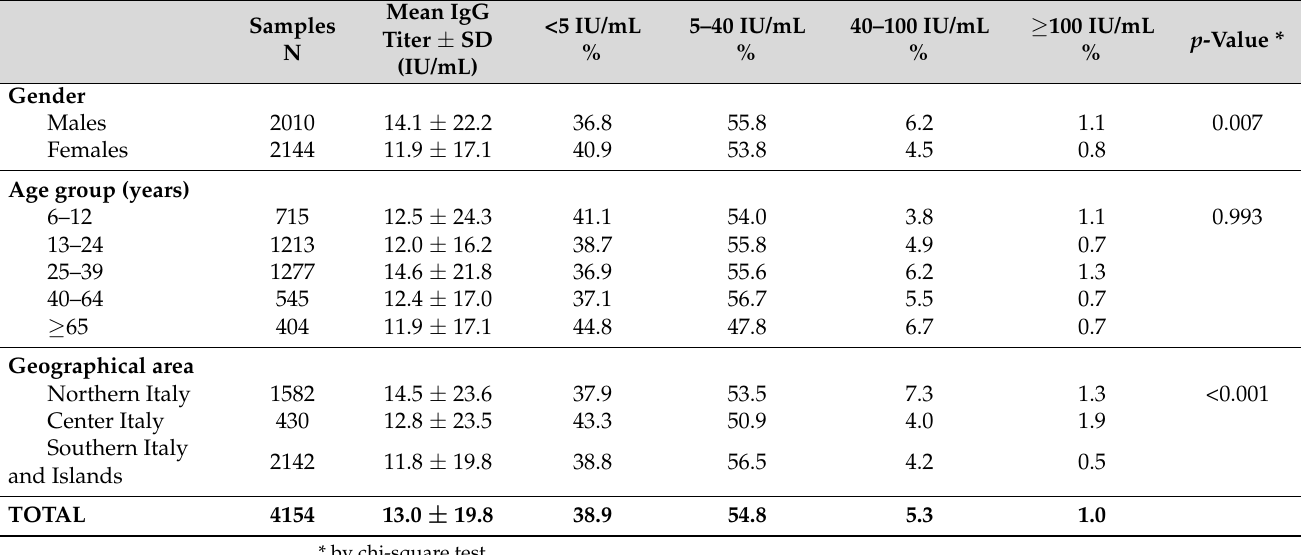
* by chi-square test.